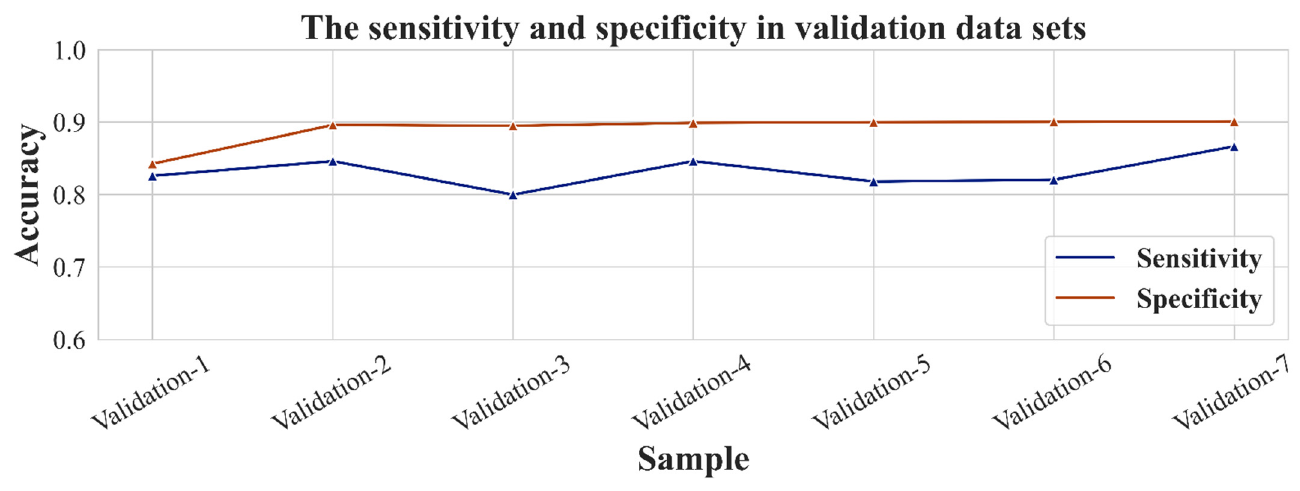
Figure B3. The results of sensitivity and specificity of the seven external validation datasets.